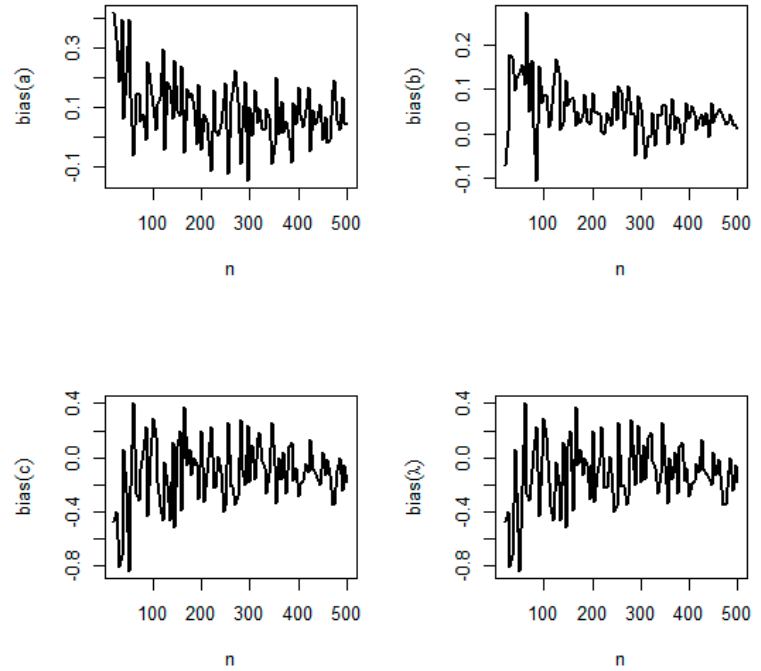
Figure 5. The biases of the estimates of parameters of the GOLE-E distribution.